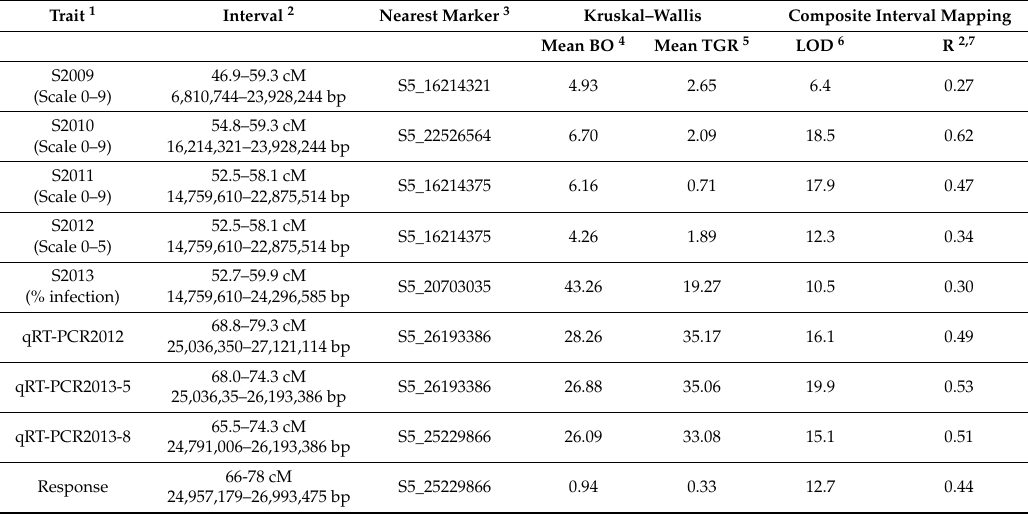
Table 1. Quantitative trait loci (QTLs) identified in chromosome 5 in the di ff erent assays with the recombinant inbred line (RIL) population derived from the cross between TGR-1551 and the cultivar ‘Bola de Oro’, phenotyped for resistance to Cucurbit yellow stunting disorder virus and genotyped by